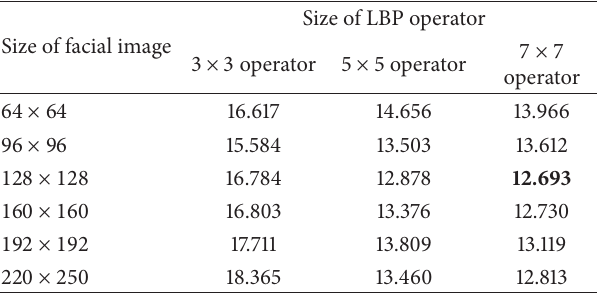
Table 8: MAEs measured by the previous MLBP method (unit: years